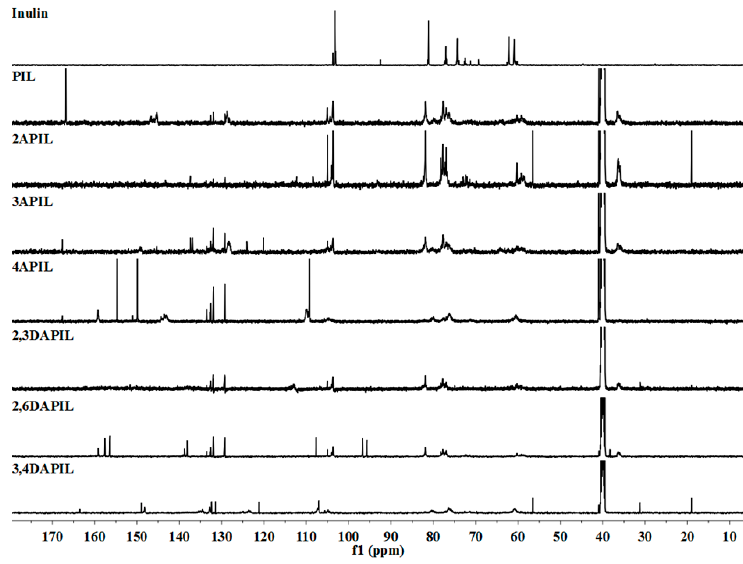
Figure 3. 13 C NMR spectra of inulin and cationic inulin derivatives.